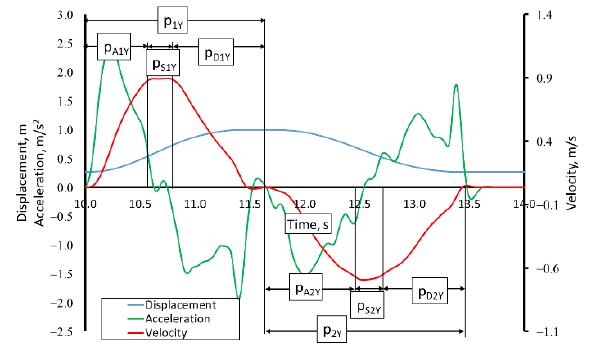
Figure 6. An example of the course of changes in displacement, velocity, and acceleration for the lateral movement of the hand (displacement: 730 mm), where p is the phase of the movement.